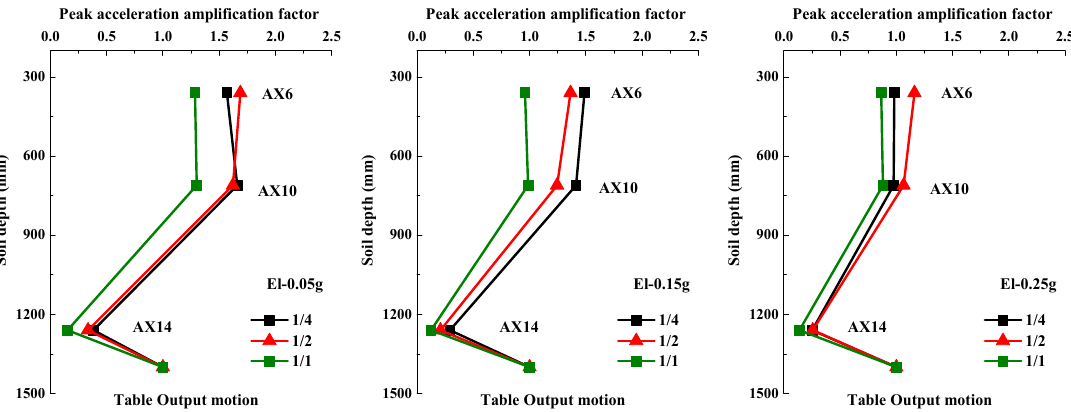
Figure 10. The peak acceleration amplification ratio of the model soil under scaled El Centro records.